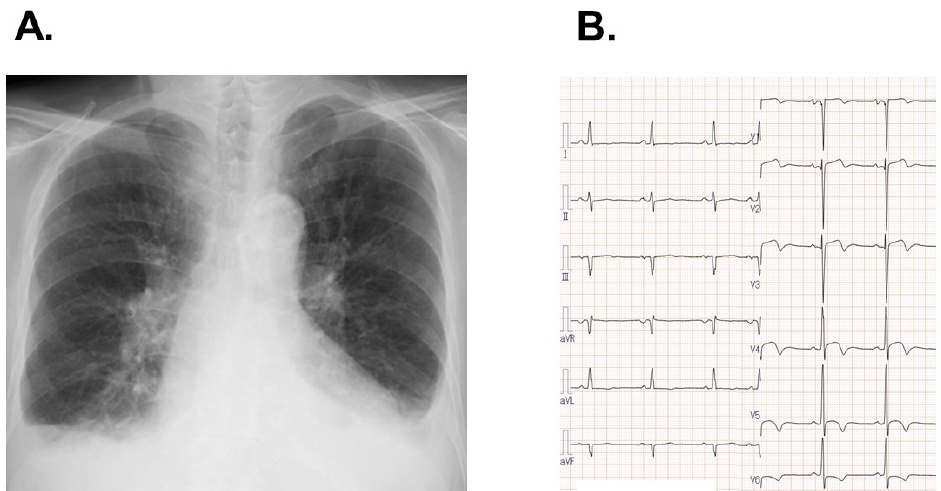
Figure 1. Chest X-ray displaying cardiomegaly, bilateral pulmonary congestion, and bilateral pleural effusion ( A ) and electrocardiogram showing heart rate of 64 bpm, sinus rhythm, and ST-segment depression in V5,6 ( B ) on admission.